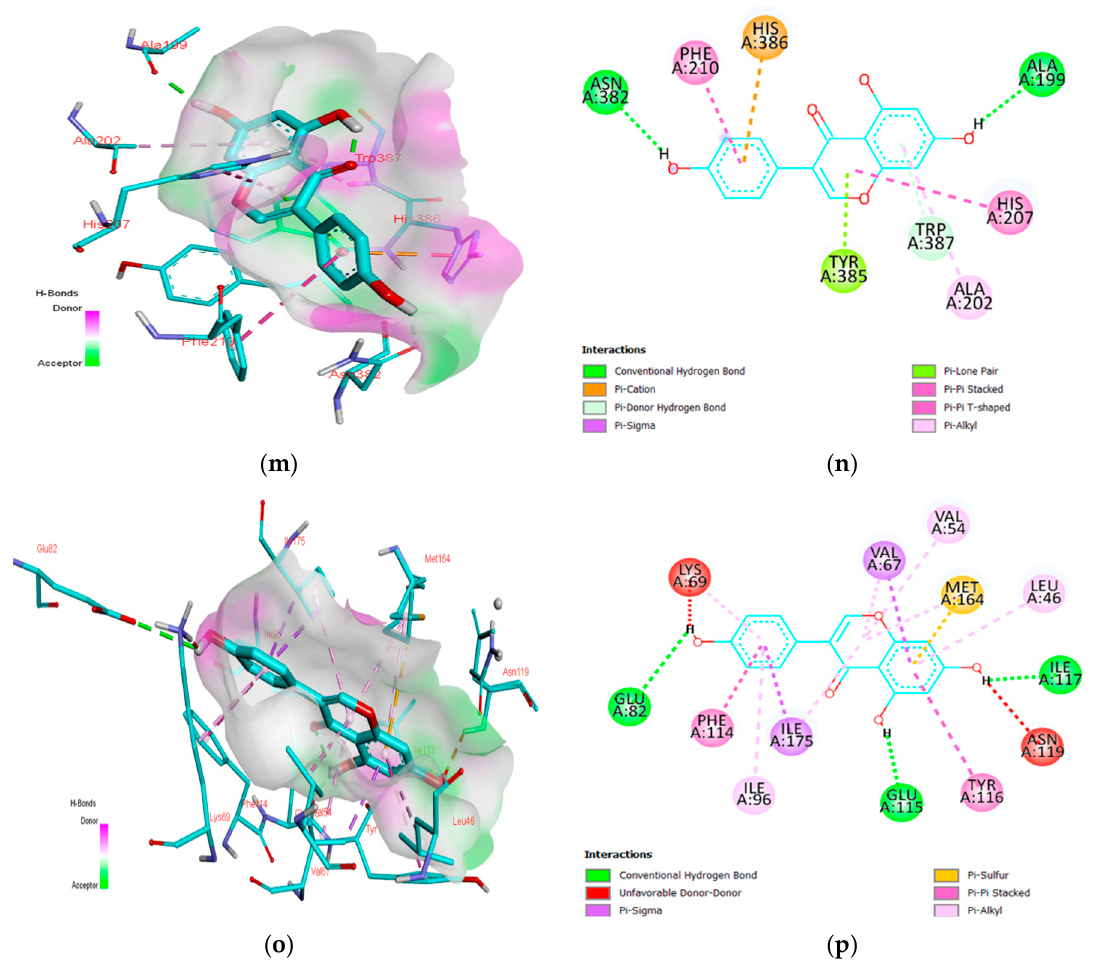
Figure 6. Schematic representation of the interaction of isoquercetin ligand on the active site of PPARy (PDB 6tsg) receptor in 3D ( a ) and 2D ( b ) structure; PPAR α (PDB 2P54) receptor in three-dimensional ( c ) and two-dimensional ( d ) structure; CK2 α (PDB 6TGU) receptor in three-dimensional ( e ) and two-dimensional ( f ) structure; 5-lipoxygenase-activating protein (PDB 2Q7M) receptor in 3D ( g ) and 2D ( h ) structure; interaction of quercetin and genistein ligand on the active site of prostaglandin H (2) synthase-1 (PDB 1Q4G) in three-dimensionsal ( i , m , respectively) and two-dimensional ( j , n , respectively) structure and CK2 α (PDB 6TGU) receptor in three-dimensional ( k , o , respectively) and two-dimensional ( l , p , respectively) structure.